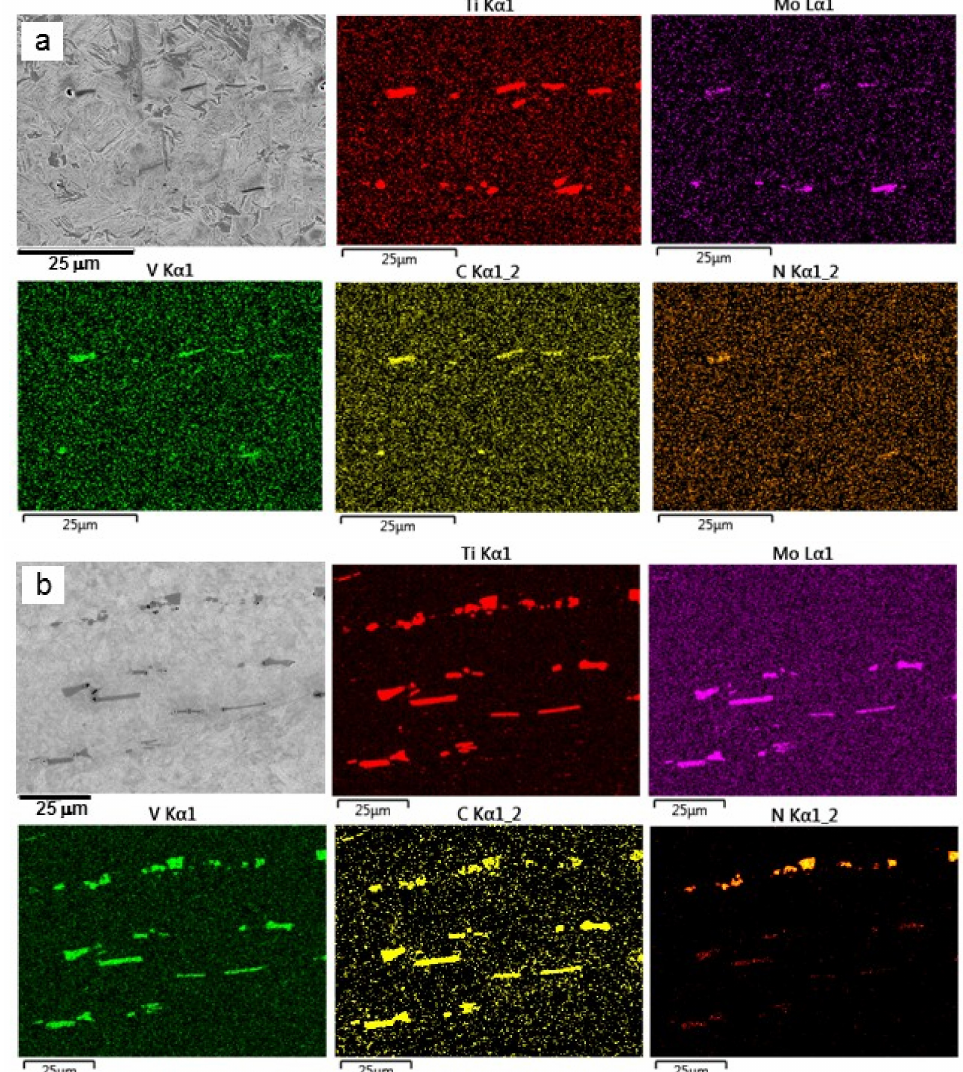
Figure 5. SEM-EDS maps of coarse particles in Steels ( a ) L and ( b ) H from selected locations.